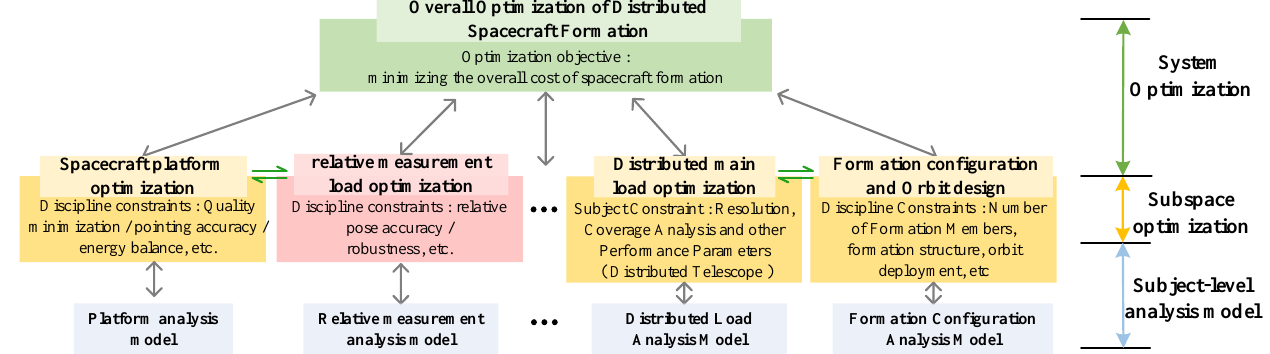
Figure 33. Multidisciplinary optimization structure diagram of the overall design of distributed spacecraft formation